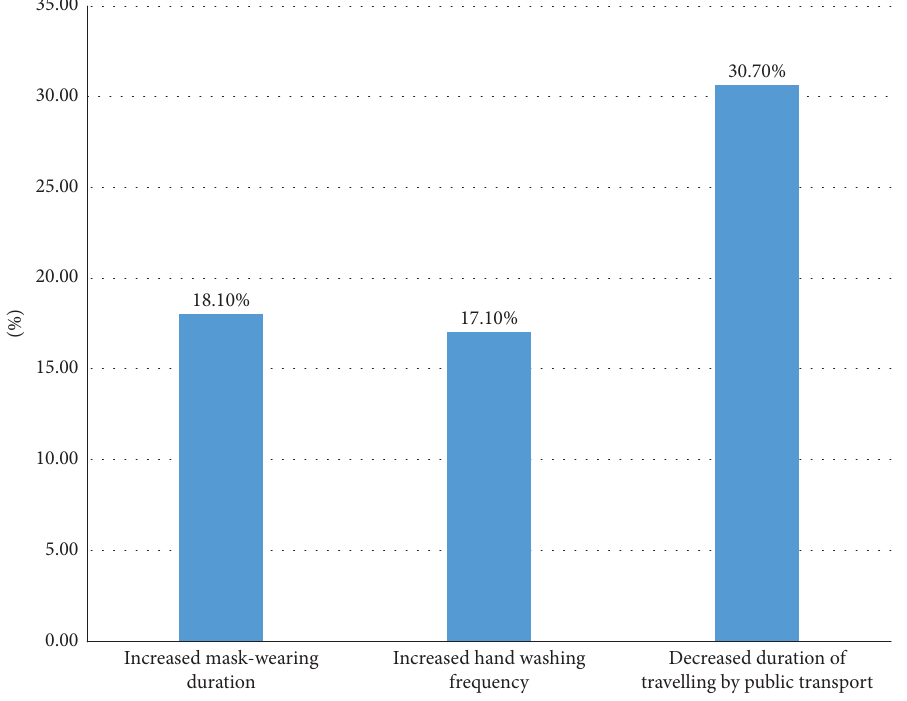
Figure 5: Comparison of travellers’ health behaviours before and after vaccination. Table 4: Experience of negative emotions (anxiety, panic, and fear) related to COVID-19 prevalence and vaccine inoculation in